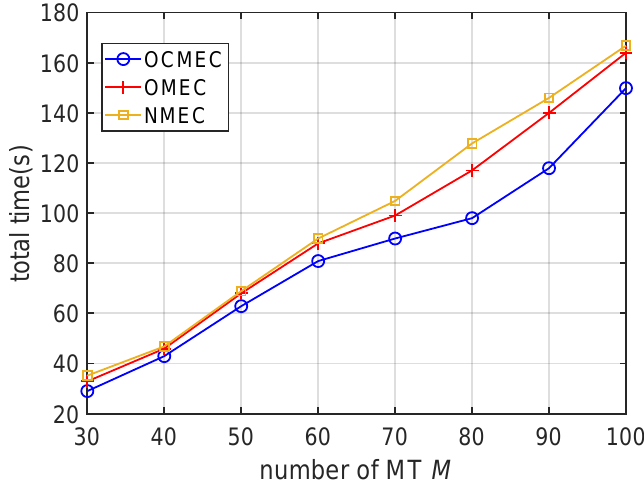
Figure 4. f gained by the 3 schemes with the increase of M